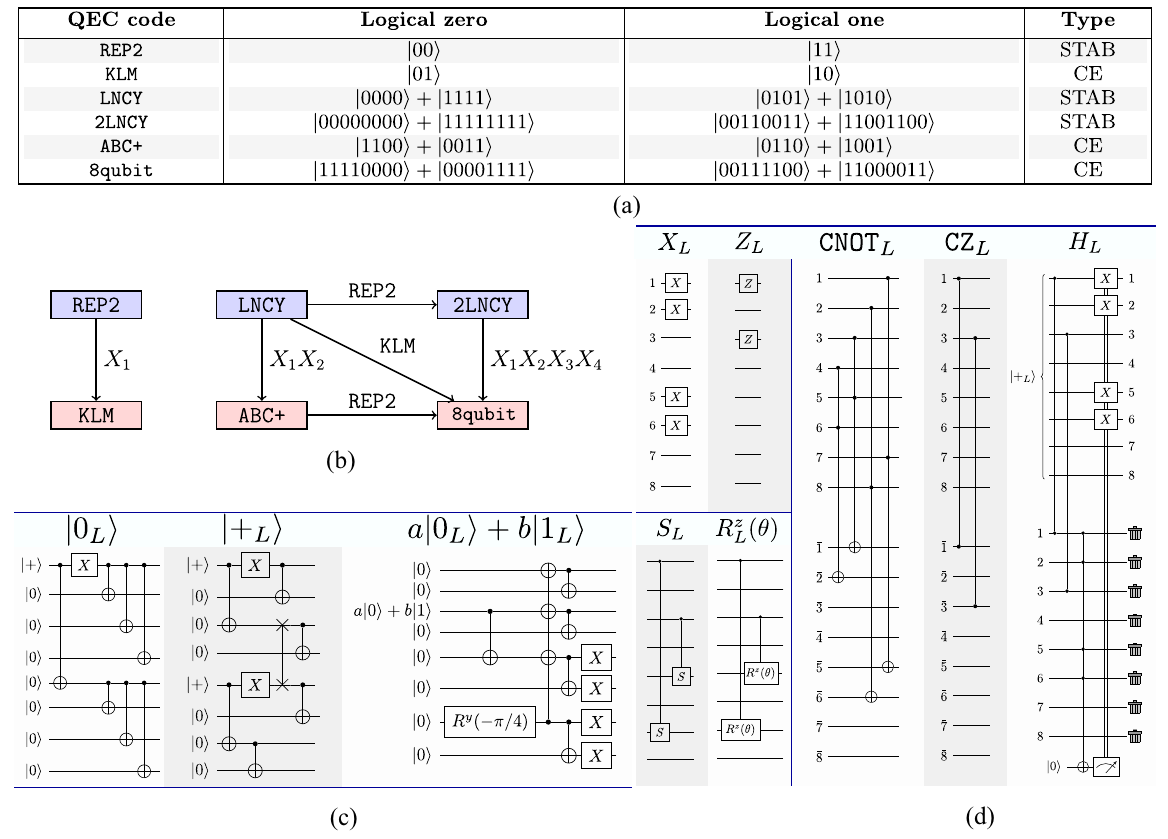
Fig. 3 An amplitude damping CE code, its relationship with other codes, encoding circuits and logical computations. a A table of various CE and stabilizer codes. The logical codewords are listed without their normalization factors. REP 2 is the two-qubit repetition code, KLM is the dual-rail code 18 , LNCY code is the four-qubit AD code 17 , a up to a permutation of qubits, ABC + is a four-qubit CE code 6 , 2 LNCY is LNCY concatenated with REP 2 and is a step to obtain our construct, and the 8 qubit code is our eight-qubit code. b We depict the relationship between the codes in a pictorially. Here X j denotes a bit ip on the j th qubit. c State preparation circuits for C 8 qubit , such as 0 L j i and þ L j i and the logical encoding of an arbitrary logical codestate. d Logical computations on C 8 qubit are depicted. Here, R z ( θ ) = e iZ θ . The logical Hadamard is performed via logical gate-teleportation after preparing a logical þ L j i ancilla. a The four-qubit AD code is also a subcode of the [[4,2,2]]